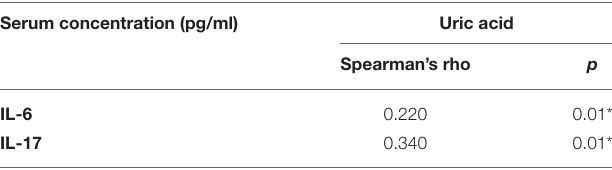
TABLE 3 | Positive correlation of UA with IL-6 serum levels before, and with IL-17 serum levels after acute treatment. Serum concentration (pg/ml)